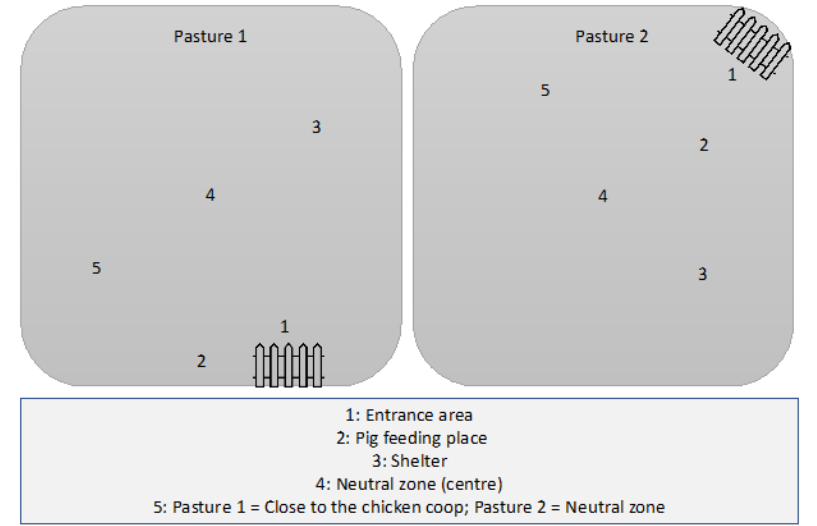
Figure 1. Schematic layout of the pastures and the soil sampling (1 to 5). Pasture 1: pigs and chickens; pasture 2: pigs